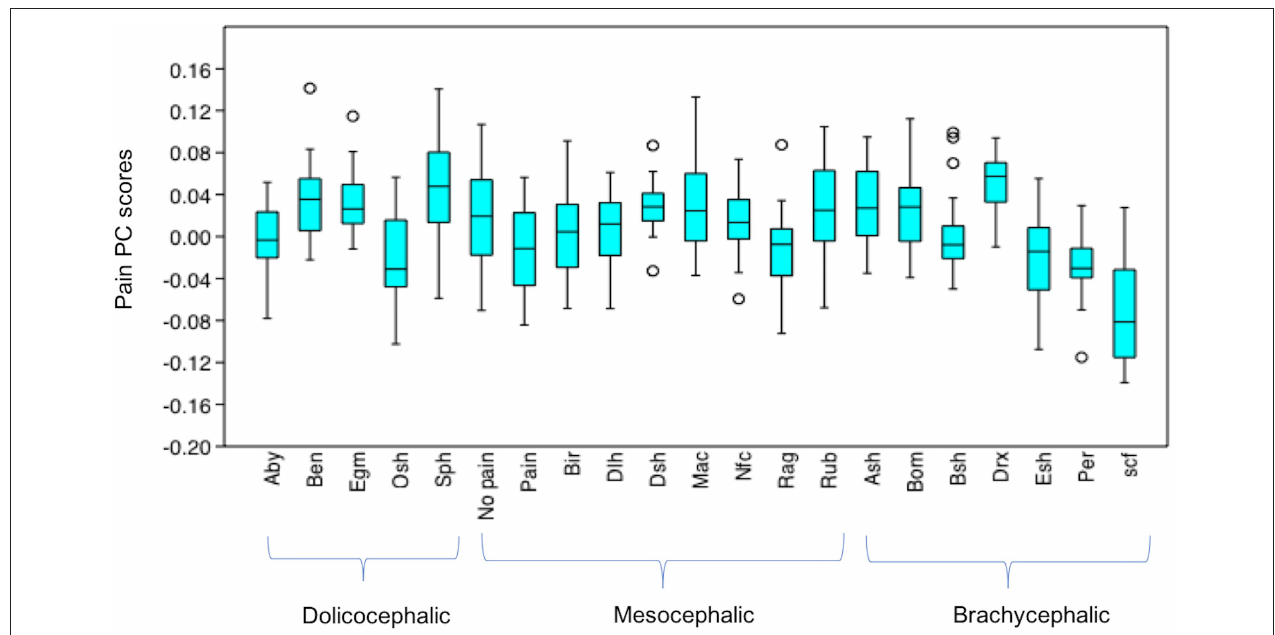
FIGURE 11 | Boxplot with minimum, first quartile, median, third quartile, maximum values and outliers for Pain PC scores for T2 (“pain” DSH population), T3 (“no pain” DSH population) and the 19 different breeds ( n = 525). A lower Pain PC is indicative of greater pain like features present. Abbreviations for breeds within each cephalic type as follows. Dolichocephalic: Aby, Abyssinian; Ben, Bengal; Egm, Egyptian Mau; Osh, Oriental Shorthair; Sph, Sphynx. Mesocephalic: Bir, Birman; Dlh, Domestic Longhair; Dsh, Domestic shorthair; Mac, Main Coon; Nfc, Norwegian Forest cat; Ragdoll, Russian Blue. Brachycephalic: Ash, American Short hair; Bom, Bombay; Drx, Devon Rex; Esh, Exotic Short hair; Per, Persian; Scf, Scottish fold. For full results of Mann Whitney U -tests see Supplementary Data 6 . For shape changes associated with higher Pain PC scores, see (